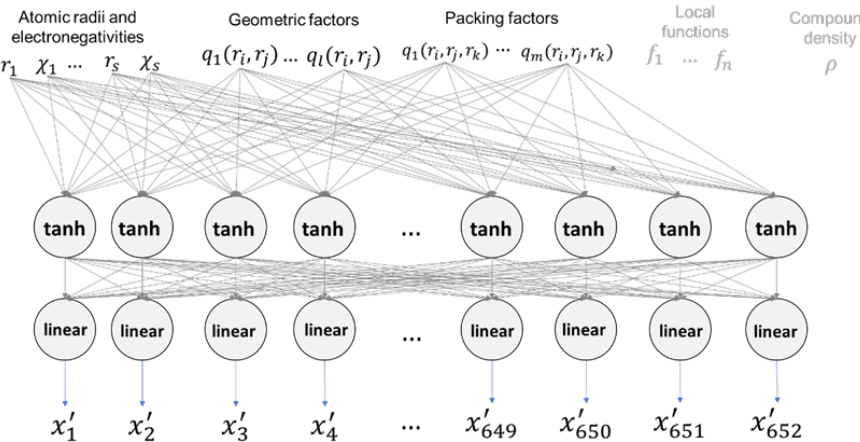
Figure 5. Feature extraction from the second hidden layer of the ANN 6S10O-WEF. Since the local functions and the compound density were not fed to the ANN, the connections of these features with the first layer are hidden. It is important to mention that the extracted features ( 𝑥′ 1 , 𝑥′ 2 , … , 𝑥′ 652 ) were the values computed by the second hidden layer prior to their activation. The extracted features were afterward used to fit a linear regression model with the lattice parameter of certain compounds.